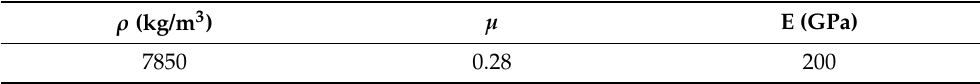
Table 3. The rigid body material model parameters of the frame and the